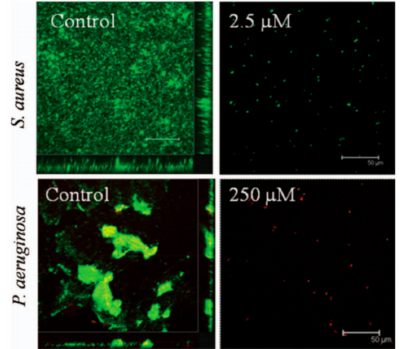
Figure 5. Biofilm formation by S. aureus and P. aeruginosa PAO1 in TSB medium (control) and in the presence of [C 12 MIM]I. S. aureus were stained with acridine orange and imaged using confocal microscopy. P. aeruginosa biofilms were stained with BacLight live/dead bacterial viability staining. Green 1 SYTO 9; red 1 propidium iodide. Adapted from 4 4